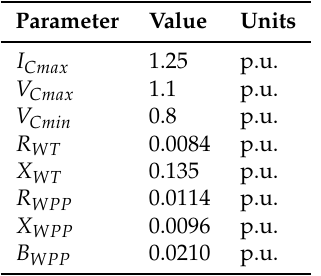
Table 2. Parameters used to plot WPP reactive power